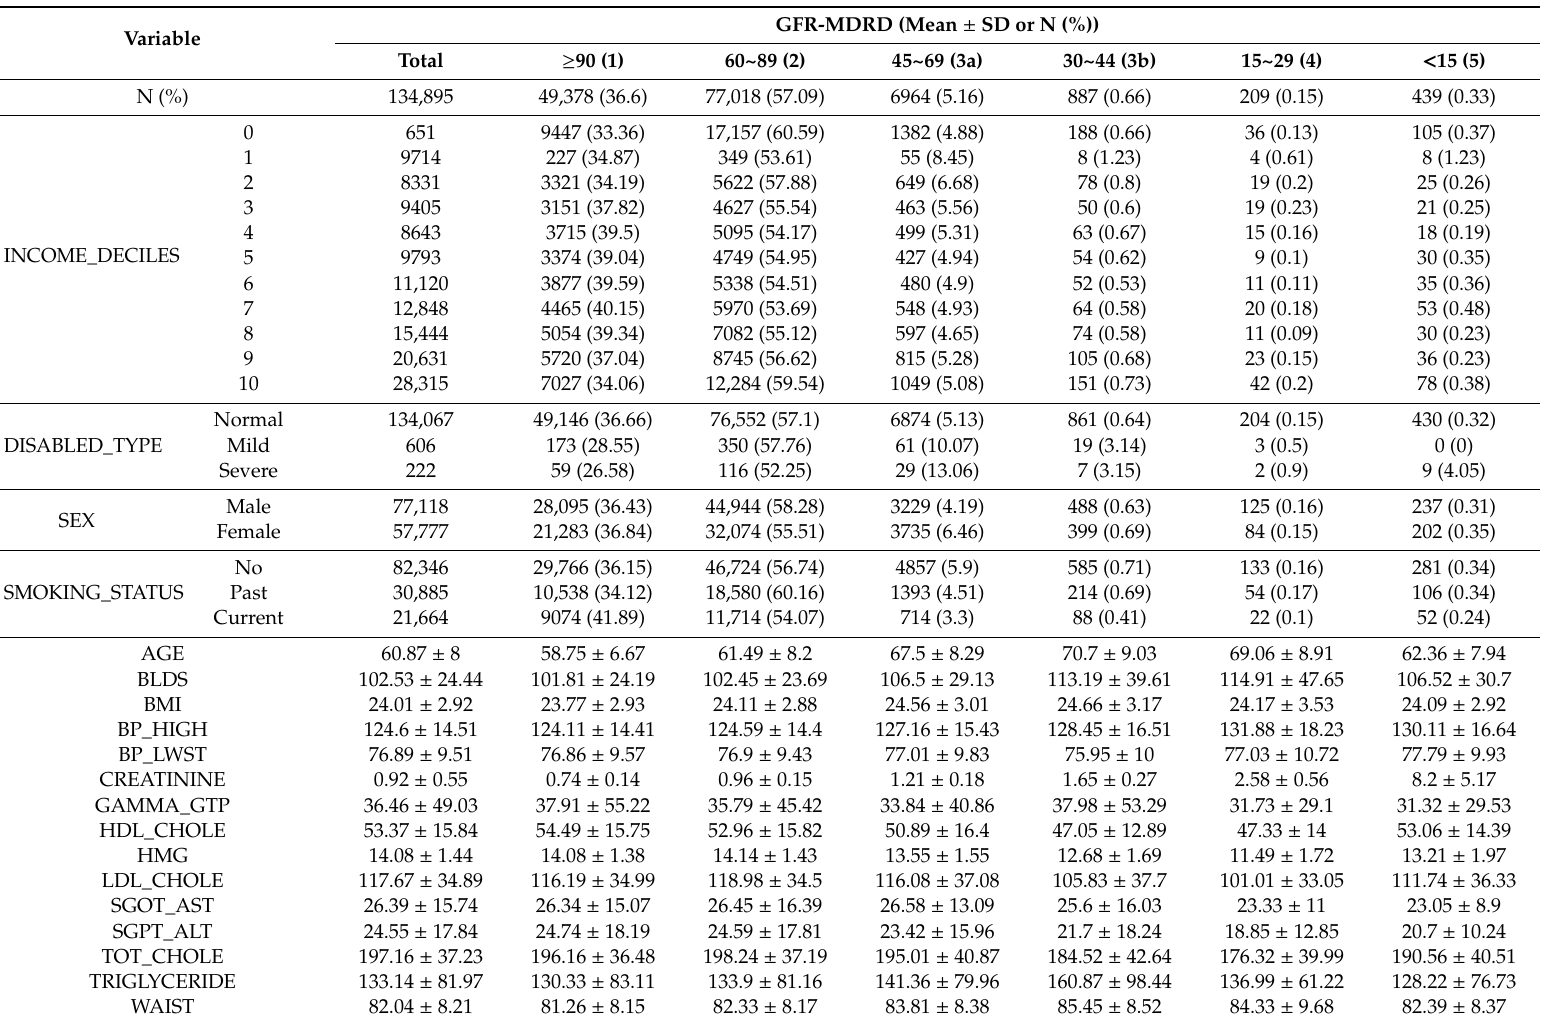
Table 3. Baseline characteristic of